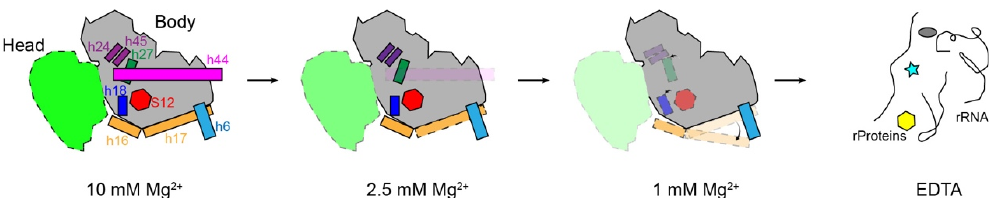
Figure 7. A model of 30S structural distortion at a low Mg 2+ concentration. Here, 2.5 mM Mg 2+ first causes the destabilization of h44 and partial loosening of h17, and the 30S head becomes more flexible. A further decrease in Mg 2+ to 1 mM shifts h17 toward the tip of h6, and h16, h18, and h27 become flexible at the same time. Ribosomal S12 near the decoding center starts to leave, causing an irreversible 30S if no additional protein is supplied. EDTA incubation was used to extract all the Mg 2+ from ribosomes and completely destroy the 30S subunit, release the ribosomal proteins, and linearize the 16S rRNA.